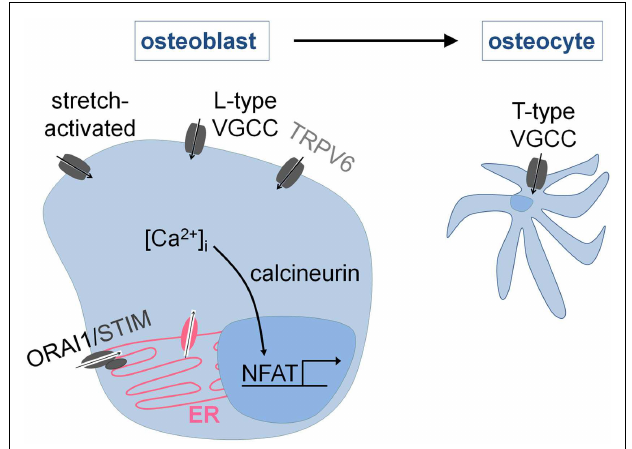
FIGURE 5 | Intracellular Ca 2 + signaling in chondrocytes. (A) Chondrocyte differentiation involves Ca 2 + entry via L-typeVGCC’s and TRPV4, that leads to the Ca 2 + /calmodulin-mediated induction of SOX9. (B) Hypo-osmotic stimuli activateTRPV4, and most likely theTRPV4 channels present on the primary cilium, leading to the increase in intracellular Ca 2 + levels which is required for the volumetric changes and chondroprotection. et al., 2008) signaling hampers chondrocyte differentiation in rat metatarsal cultures, chondrogenic cell lines, and chicken chondrocytes respectively. Thus, Ca 2 + influx via VGCC’s and TRPV4 (see TRPV4) is required for proper chondrogenesis ( Figure 5A